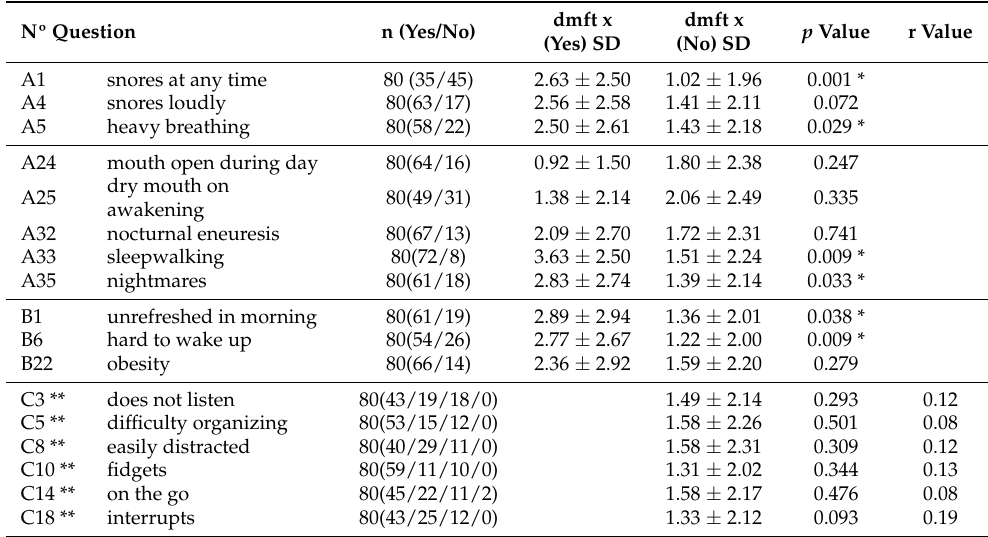
Table 5. Relationship between sleep disorders and the dmft. Mean value of dmft and the sleep disorder with its standard deviation (SD).